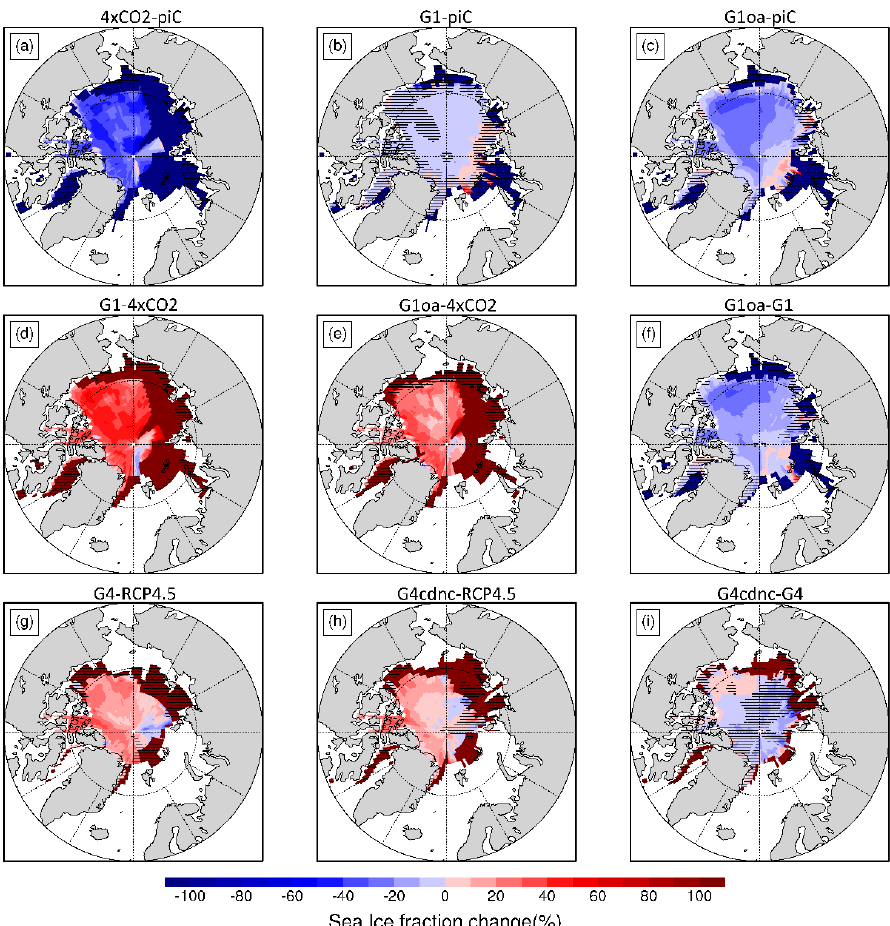
Figure 10. Six ESMs and ensemble mean Arctic minimum sea ice fraction percentage changes (defined as the limit of the 15% ice concen- tration region) in September in different scenarios (11–50years). Stippling indicates regions where differences are not significant at the 95% level according to the Wilcoxon signed-rank